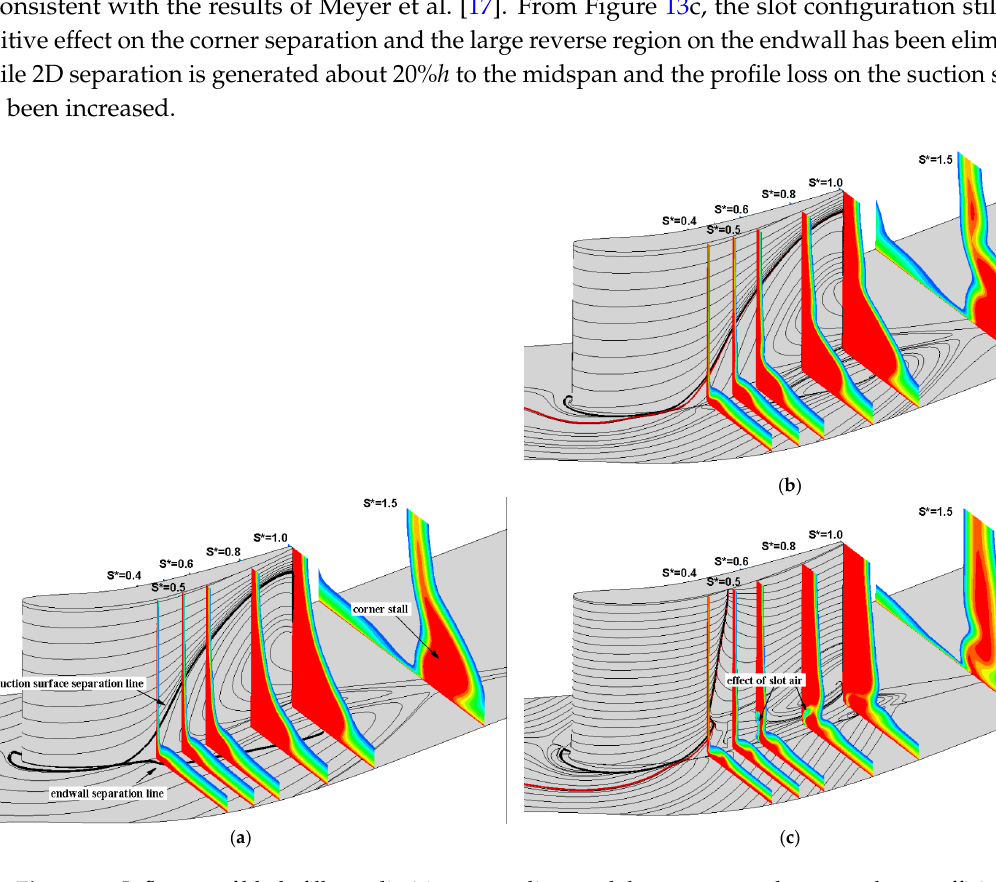
Figure 13. Influence of blade fillet on limiting streamlines and the passage total pressure loss coefficient at the i = 3 ° incidence angle: ( a ) origin, r fillet /c = 0%; ( b ) origin, r fillet /c = 1.6%; and ( c ) slot, r fillet /c = 1.6%.